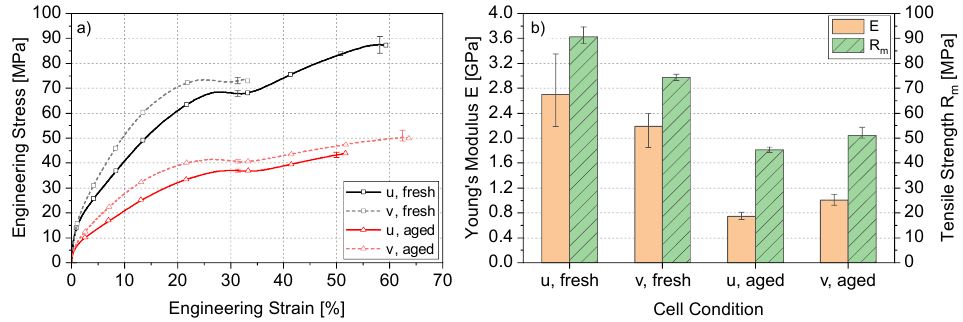
Figure 4. Experimental results of the tensile test for fresh and electrically aged polyethylene separators in different cell directions: ( a ) Shows the stress–strain curves and ( b ) the comparison of Young’s modulus and tensile